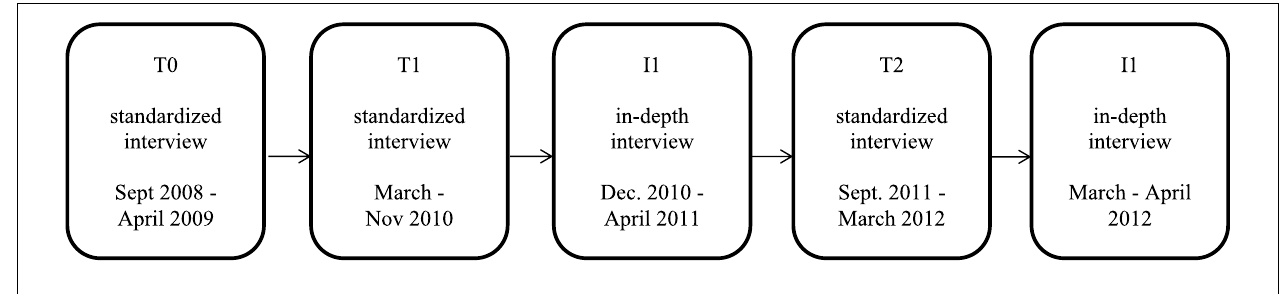
FIGURE 1 |Timeline of CanDep data collection .